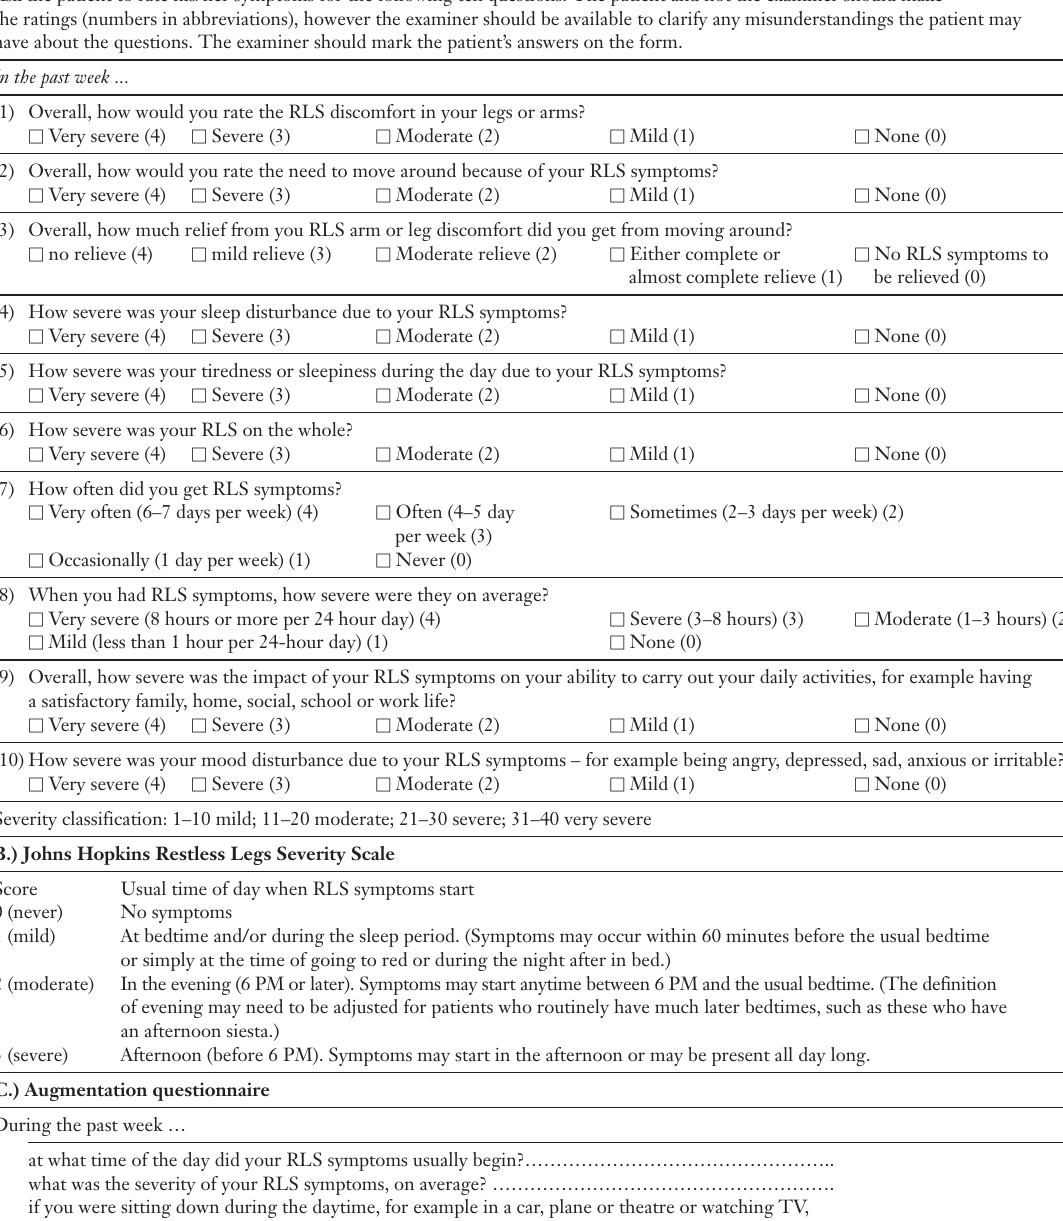
Table 2 RLS Severity